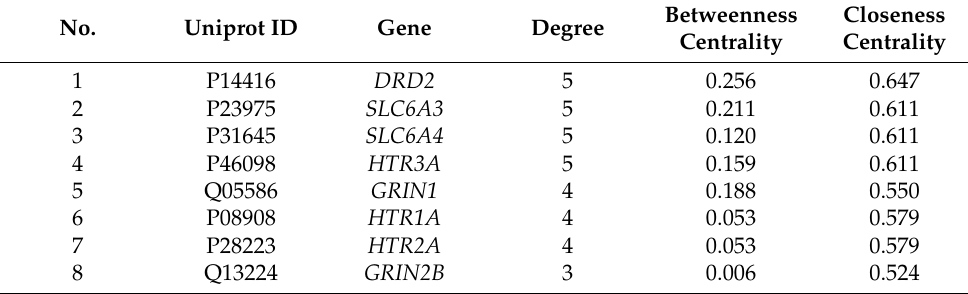
Table 4. Hispidulin anti-obesity key targets identified based on PPI network topological